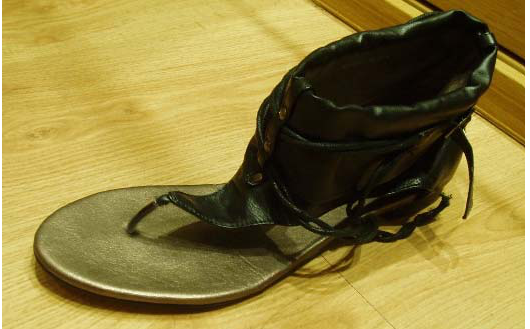
Figure 7. Sandal model used in the study. A free toe ‐ tip ‐ box is present to allow movement of proximal phalanx of the hallux and first metatarsal bone.